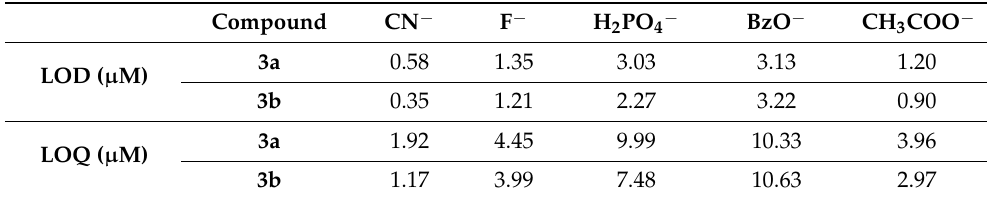
Table 1. LOD and LOQ of compounds 3a–b for the five anions in